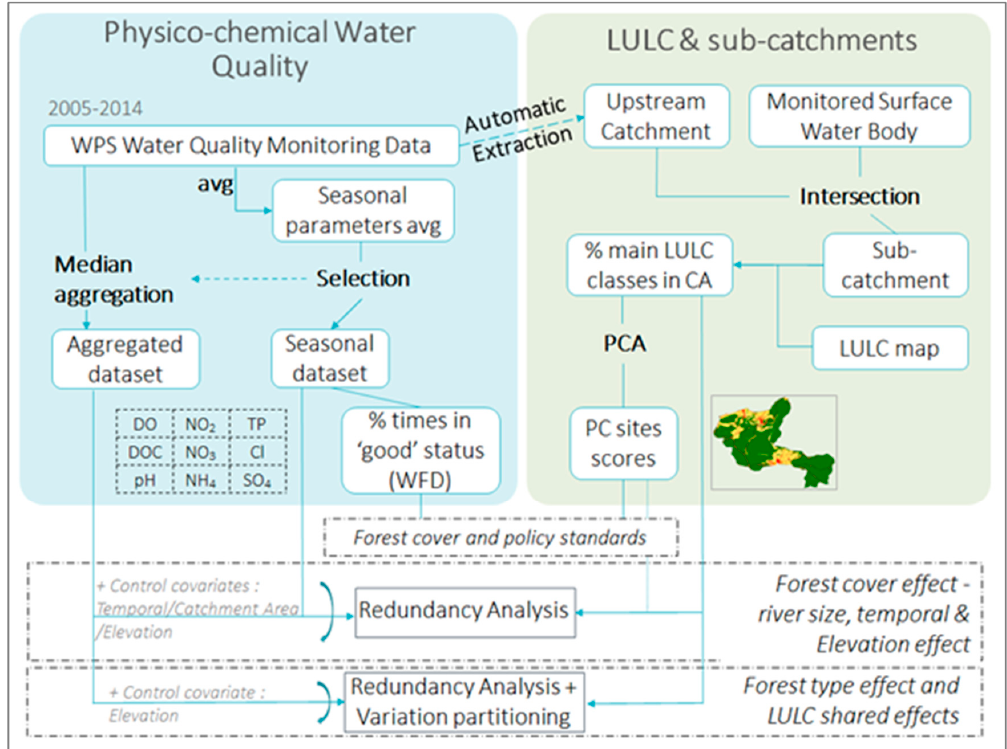
Figure 3. Schematic figure of the methodological approach to link forest cover and water quality. WPS: Walloon Public Service; avg: average; WFD: Water Framework Directive; PCA: Principal Component Analysis.